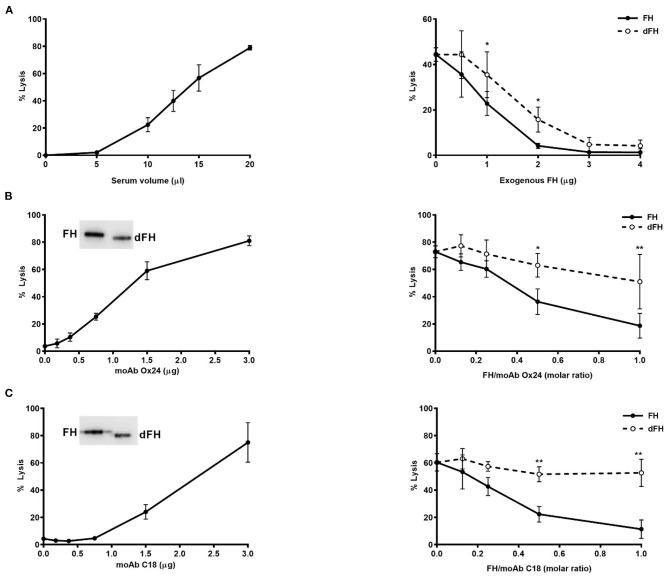
Haemolytic assays on sheep erythrocytes. (A) Lysis of sheep erythrocytes by the serum from an aHUS patient carrying the mutation W1183L in FH (left panel). The lysis generated by 12.5 μL of patient's serum (about 50%) could be prevented by addition of exogenous FH or dFH, but dFH was less effective (right panel). (B,C) Lysis of sheep erythrocytes was induced by adding increasing amounts of monoclonal antibodies OX24 (B) or C18 (C) to 20 μL of NHS (left panels). MoAb OX24 recognizes FH SCR4 domain, and MoAb C18 recognizes FH SCR20 domain; both antibodies recognize similarly FH and dFH by Western-blot (insets). The lysis induced by 1.6 μg of OX24 (about 70%) or C18 (about 60%) could be inhibited by adding increasing concentrations of FH or dFH, although dFH was less effective (right panels). All curves represent the mean ± SD from three independent experiments. *P < 0.05; **P < 0.01.